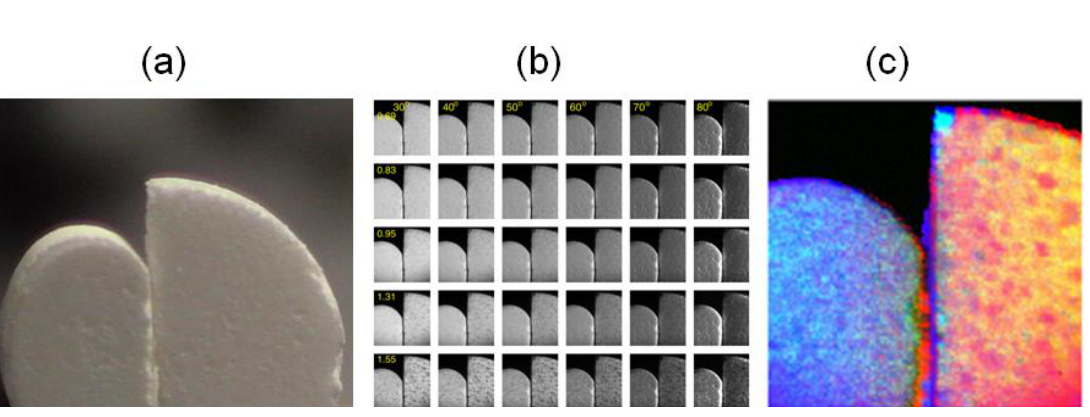
Figure 15. (a) A conventional visible photograph of two drug pills. (b) Scattering coefficient images for wavelength from 0.69 from 1.55  m (vertical, column) and for viewing angle from 30-80 degree (horizontal, row). (c) False color image of scattering properties of the two pills, taking into account both angular and wavelength